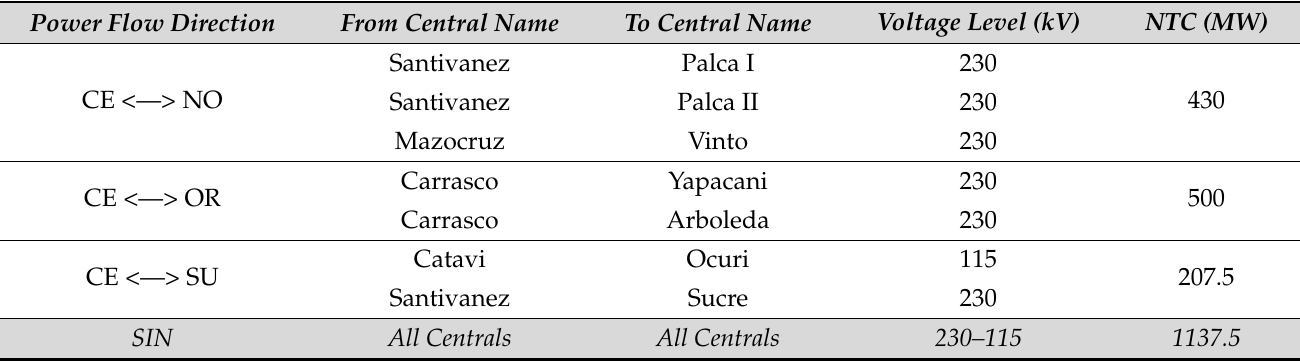
Table 4. Transmission Capacity between zones in 2020